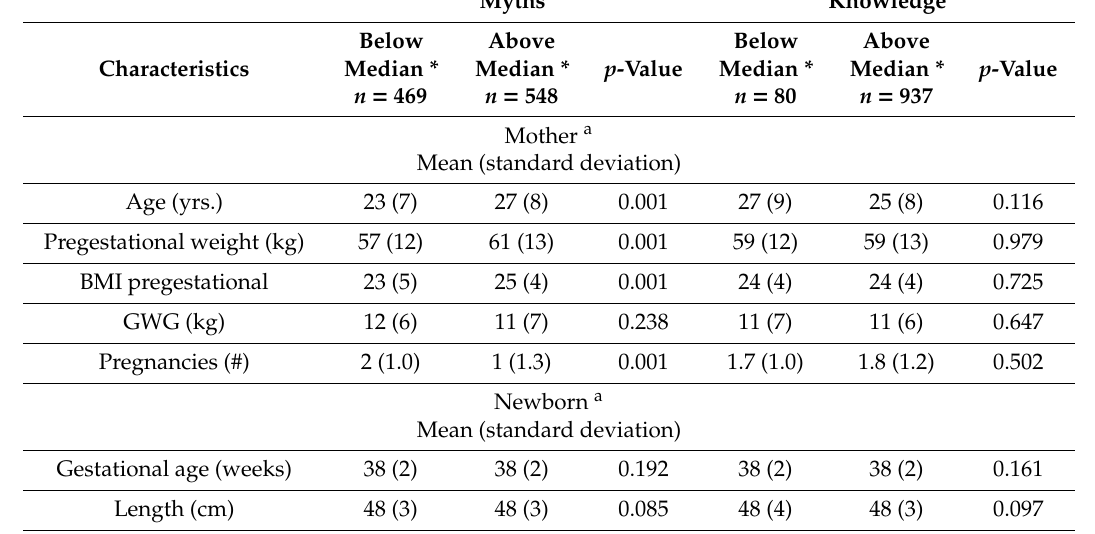
Table 2. General characteristics of the participants, according to median myths and knowledge score.